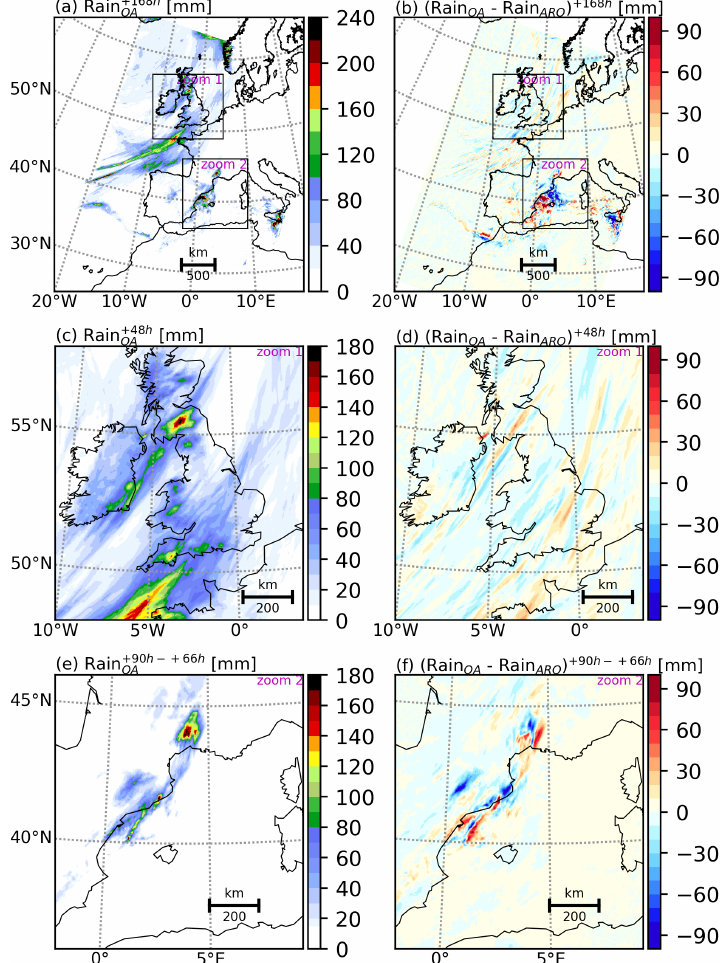
Figure 14. Accumulated precipitation (mm) simulated by the coupled (OA) simulation (left column) and differences with the ARO-forced simulation (right column): (a, b) total amounts over the 7d period, 24h accumulated amounts (c, d) over the British Islands between 12 October, 00:00UTC and 13 October, 00:00UTC ( + 00 to + 24h forecast ranges) and (e, f) over the western Mediterranean area between 14 October, 18:00UTC and 15 October, 18:00UTC (between + 66 and + 90h forecast ranges).